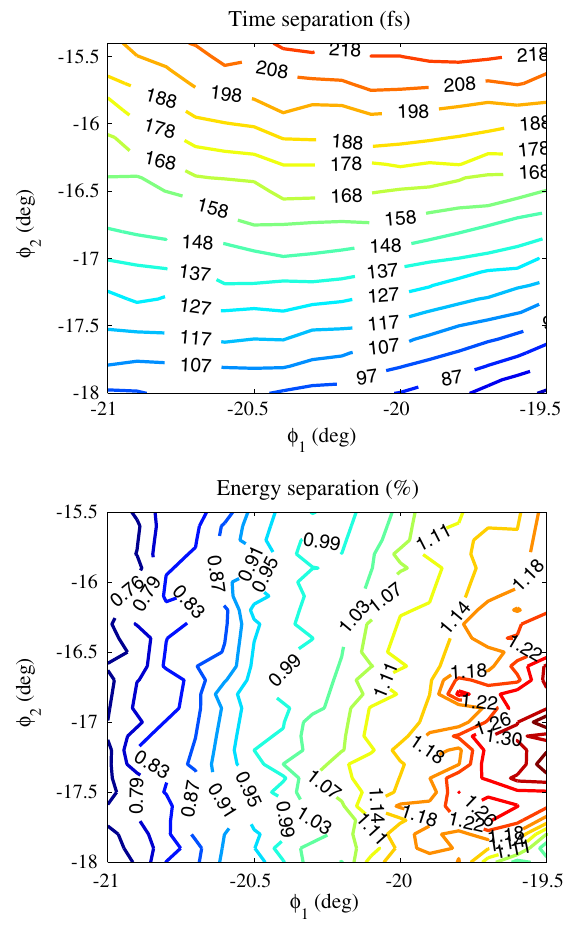
FIG. 7. Length of the corrugated plate equivalent to the ¼ 1 . 5 m) as a function of a (left reference case ( a ¼ 2 mm, L P axis) and wavelength of the corrugated plate as a function of the semiaperture (right